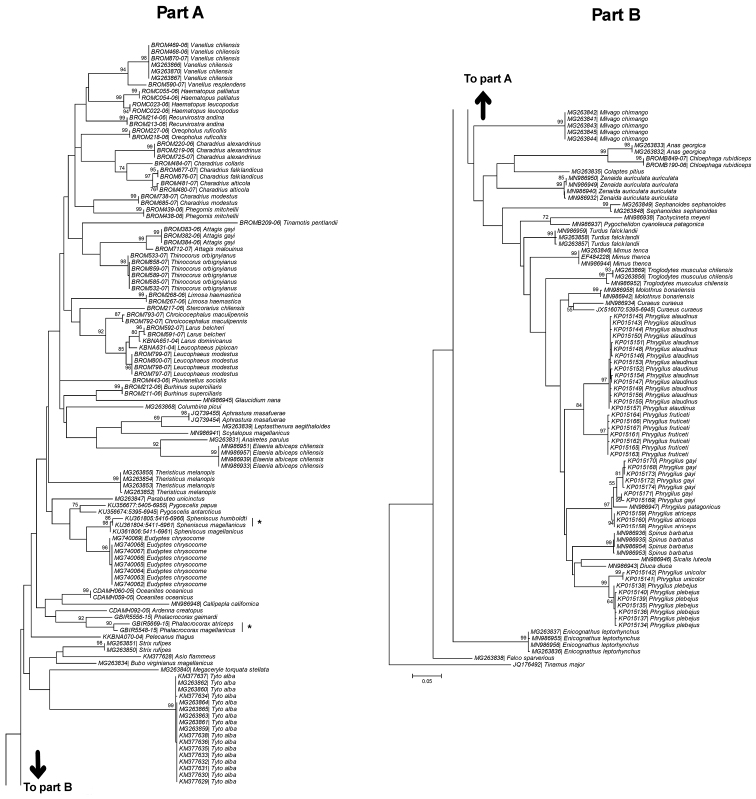
Maximum likelihood (ML) tree derived from the analysis of COI sequences for 76 bird species from Chile. The numbers at the nodes represent the percentage of bootstrap support. GenBank or BOLD accession number for each specimen are shown. Scale indicates the sequence divergence estimated from the number of nucleotide substitutions per site. The asterisk indicates the contradictory clusters found in the tree. Charadrius
alexandrinus is currently known as Charadrius
nivosus.